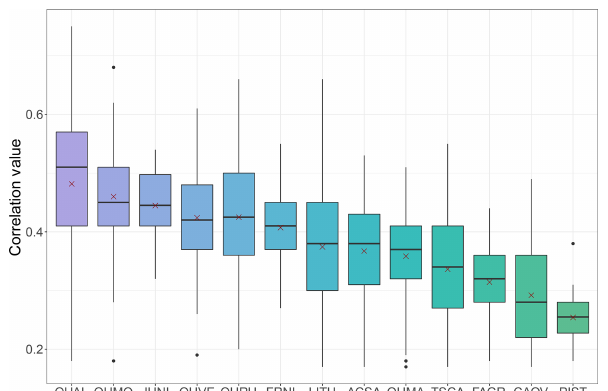
Figure 8. Correlation values between species chronologies and PMDI for the gridded reconstruction models. The “ x ” represents the mean beta weight for the species: QUAL is Q. alba , QUMO is Quer- cus montana , JUNI is Juglans nigra , QUVE is Q. velutina , QURU is Q. rubra , FRNI is Fraxinus nigra , LITU is Liriodendron tulip- ifera , ACSA is Acer saccharum , QUMA is Q. macrocarpa , TSCA is Tsuga canadensis , FAGR is Fagus grandifolia , CAOV is Carya ovata , and PIST is Pinus strobus . The species are ranked by their mean correlation values from highest to